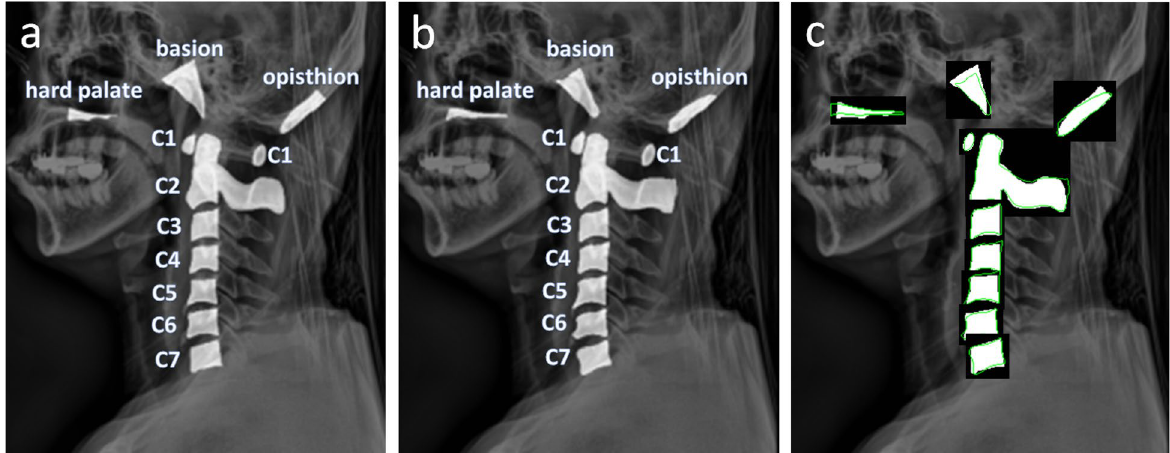
Figure 3. Example of overlapping predicted masks and ground truth masks for calculating dice coefficient. ( a ) Ground truth masks manually annotated. ( b ) Predicted segmentation masks (c) overlap of ground truth masks (white contours) and predicted segmentation masks (green outline) to calculate dice